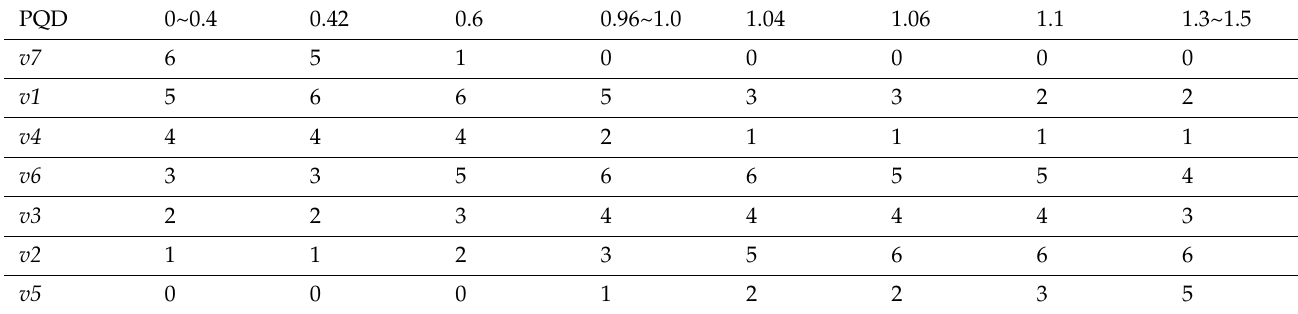
Table 7. Scores of each class for voltage variation at Obs ‐ 12.